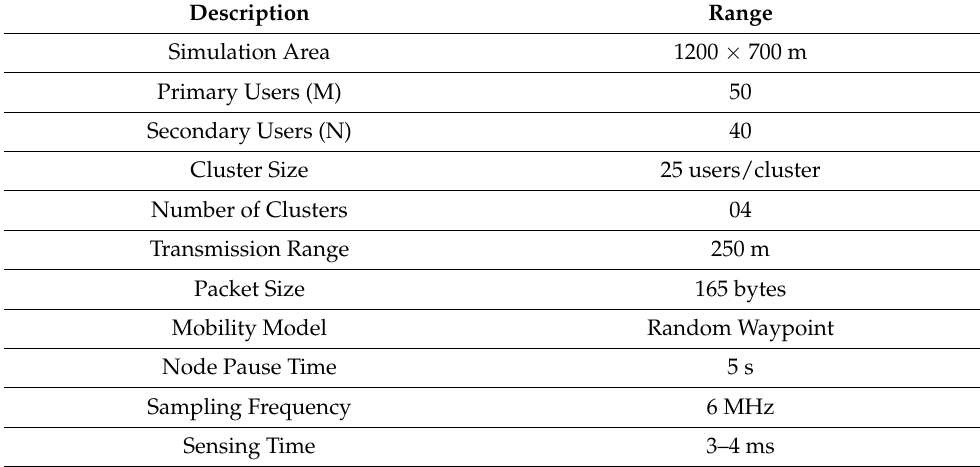
Table 1. Simulation